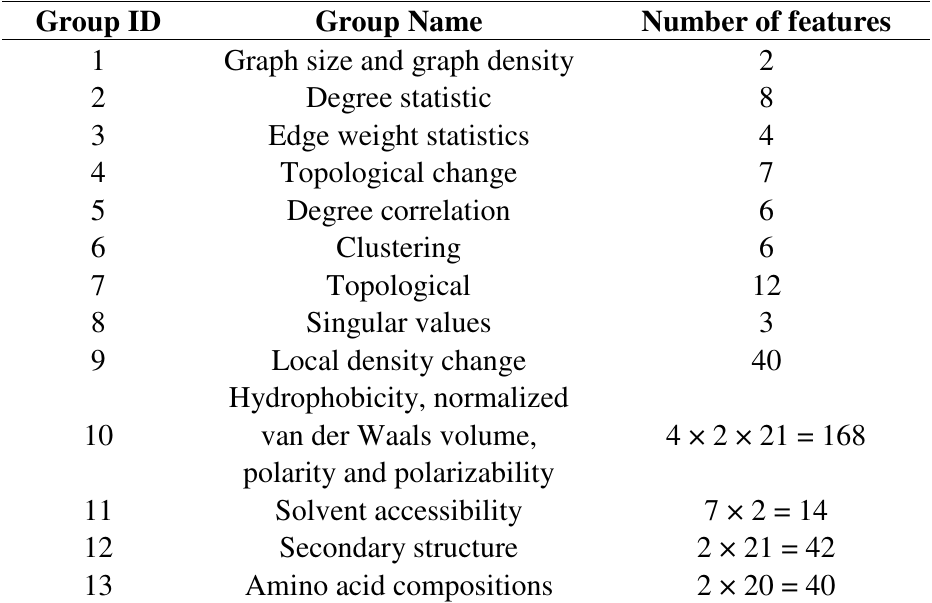
Table 2. The distribution of 352